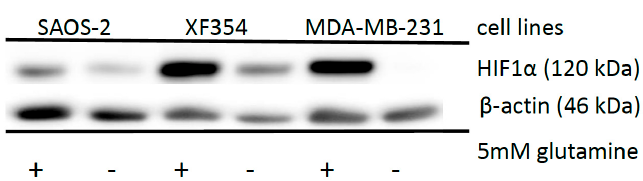
Figure 3. Altered HIF1 α expression after the application of acetylsalicylic acid or ibuprofen in different cell lines under normoxia. Saos ‐ 2, XF354 and MDA ‐ MB ‐ 231 cells were treated with 10 mM